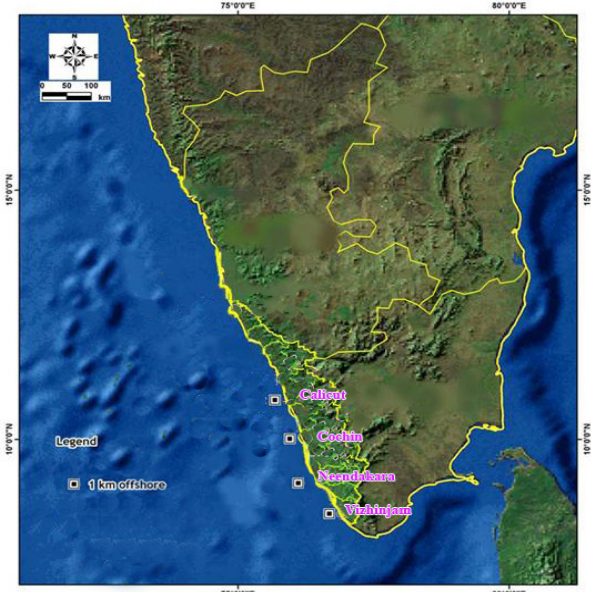
Fig. 1. Area of investigation along southwest coast of India